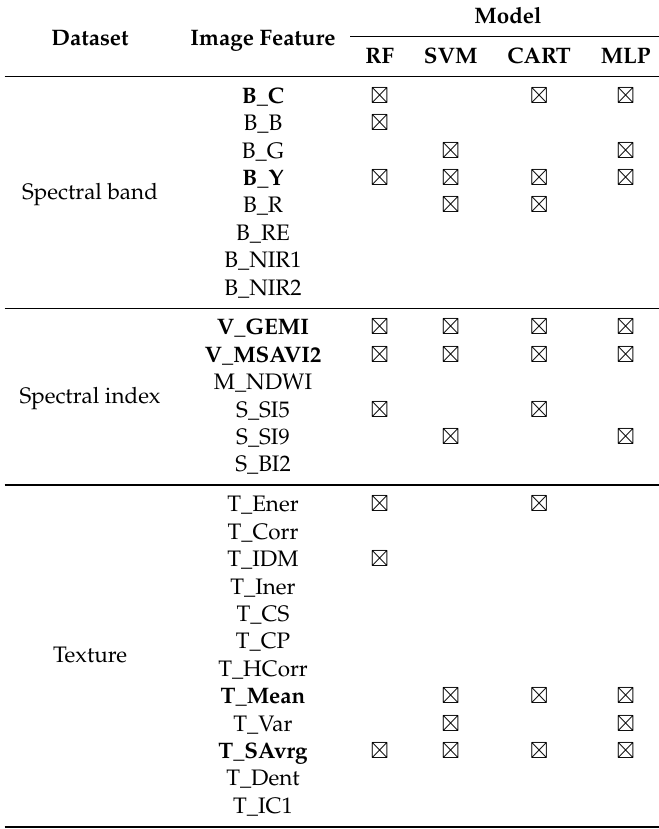
Table 5. Summary of the first three most important image features from spectral bands, spectral indices and texture variables across all models. Image features that appear in at least three models are in bold. For the detailed names and description of image feature acronyms, refer to Table